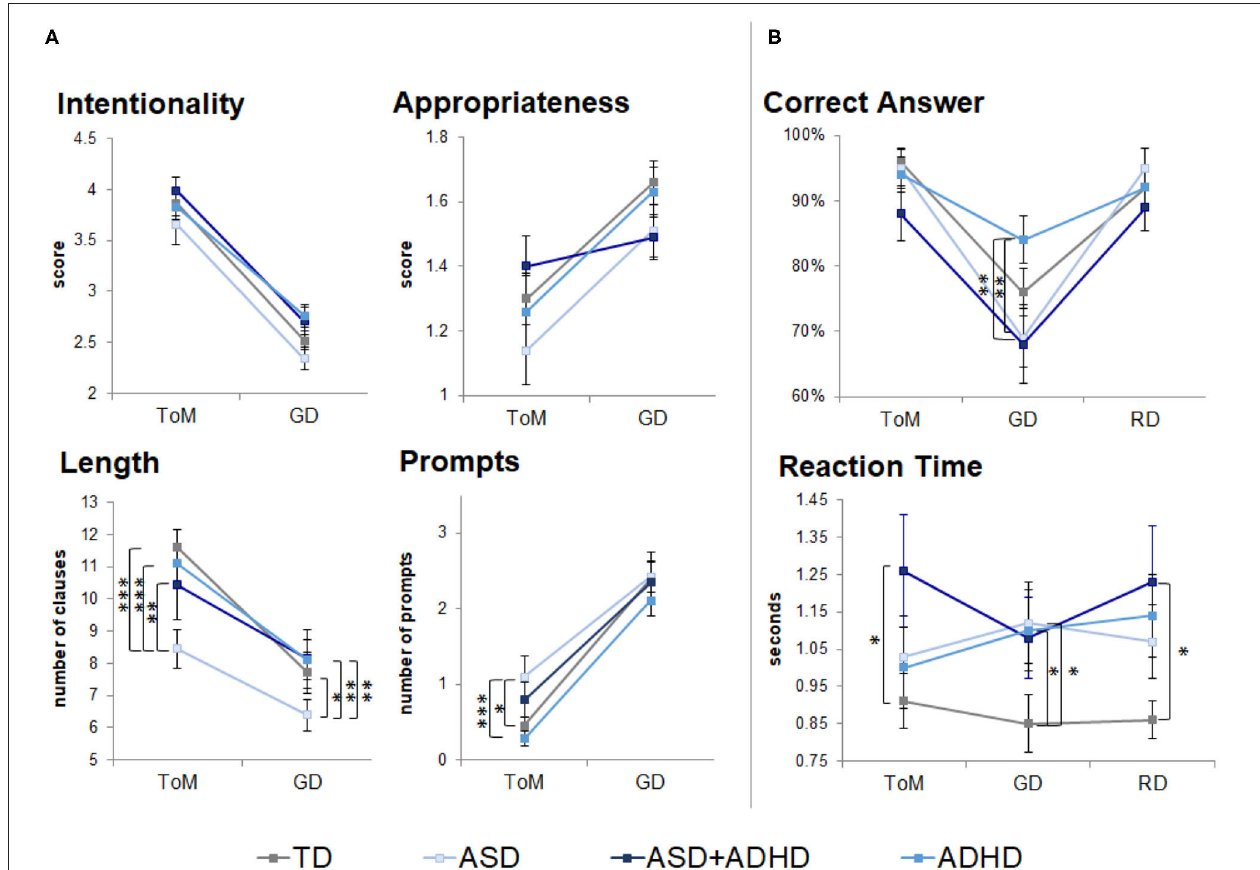
FIGURE 1 | Behavioral performance outside (neuropsychological task) and during fMRI scanning (fMRI task). TD, typical development; ASD, autism spectrum disorder; ADHD, attention-deficit/hyperactivity disorder; GD, goal directed; RD, random movement; ToM, theory of mind. Only pairwise group differences are highlighted although an effect of condition was found in scores for intentionality, appropriateness, length of descriptions and number of prompts during neuropsychological task. An effect of condition was also found for correct identification of motion (correct answers) during the fMRI task. * p < 0.05, ** p < 0.01, *** p < 0.001, with Tukey–Kramer multiple comparison correction. Error bars represent standard error of the mean. (A) Neuropsychological task behavioral results. (B) fMRI task behavioral